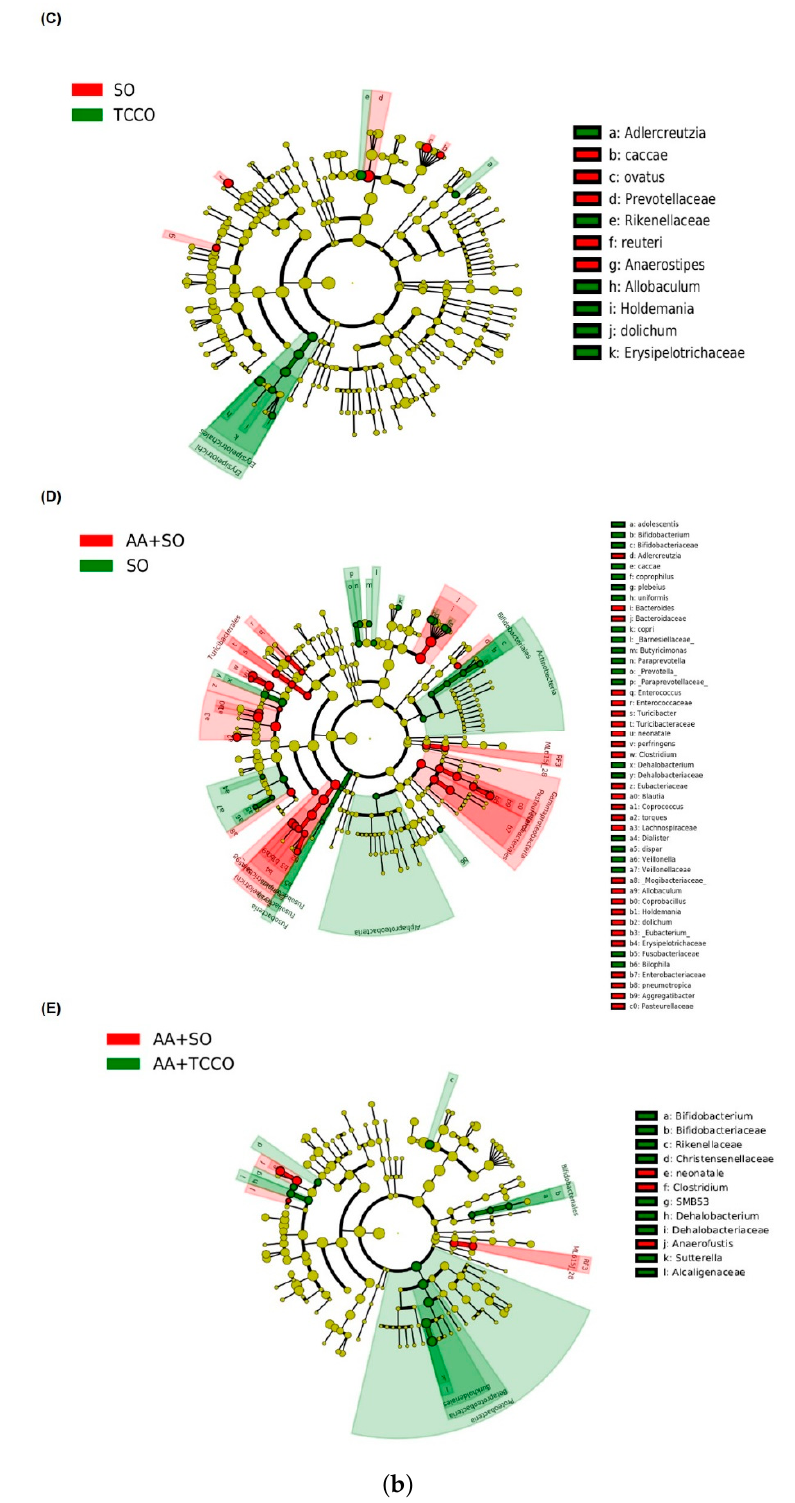
Figure 6. Alpha diversity indices of richness of gut microbiota composition in Sprague–Dawley rats fed SO, PCO, TCCO, or OO on days ( A ) 21 and ( B ) 24. The boxplot demonstrates the distribution summary of diversity indices estimated at the OUT level. ( C ) Cladogram generated from linear discriminant analysis (LDA) effect size (LEfSe) analysis, showing the most differently abundant taxa enriched in the microbiota obtained from the rats fed SO (red) or TCCO (green). The rats received an oral administration of TCCO or SO for 3 weeks. ( D ) LDA-LEfSe analysis, showing the most differently abundant taxa enriched in the microbiota from the rats fed AA + SO (red) or SO (green). The rats received oral administration of SO for 3 weeks. Subsequently, AA was administered intrarectally for